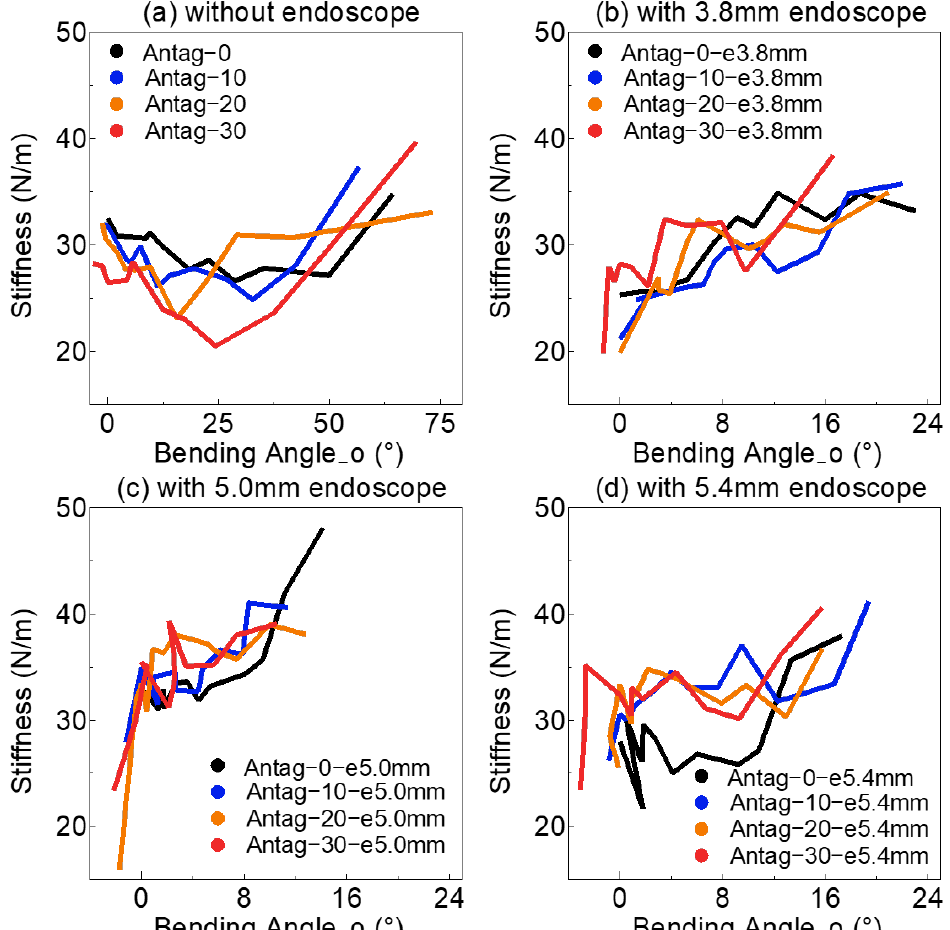
Figure 5. The variation of soft actuator’s stiffness under different sets of FU air pressure and FD air pressure ( a ) without endoscope: without inserting endoscope into soft actuator for experiment, ( b ) with 3.8 mm endoscope: inserting 3.8 mm endoscope into soft actuator for experiment, ( c ) with 5.0 mm endoscope: inserting 5.0 mm endoscope into soft actuator for experiment, ( d ) with 5.4 mm en- doscope: inserting 5.4 mm endoscope into soft actuator for experiment.